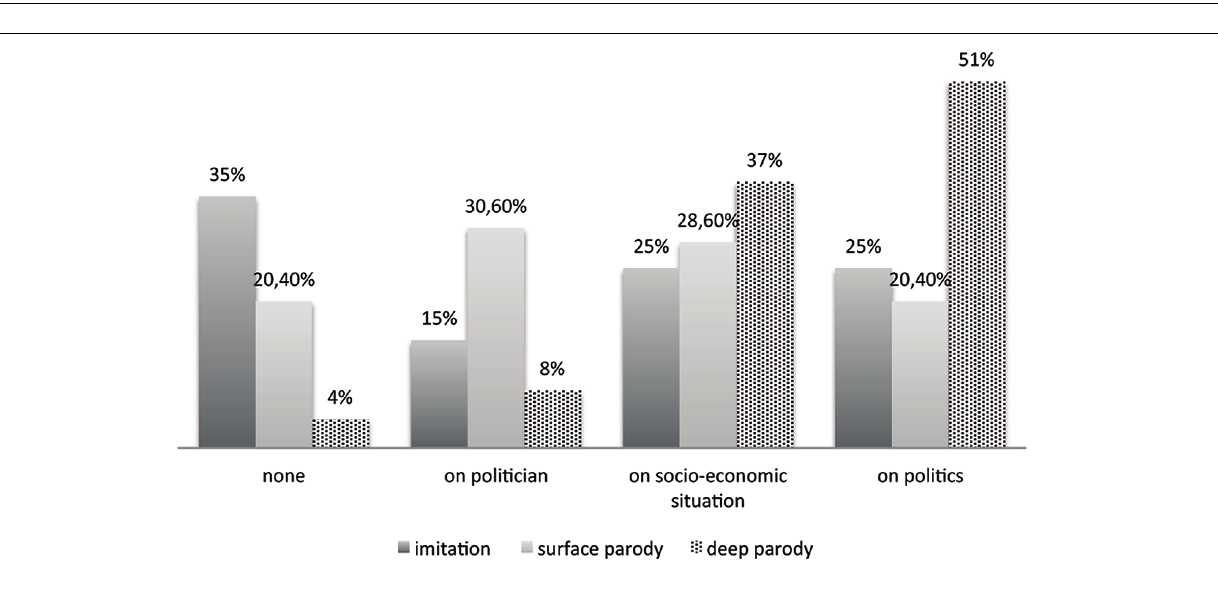
FIGURE 3 | Target of distrust ∗ conditions.